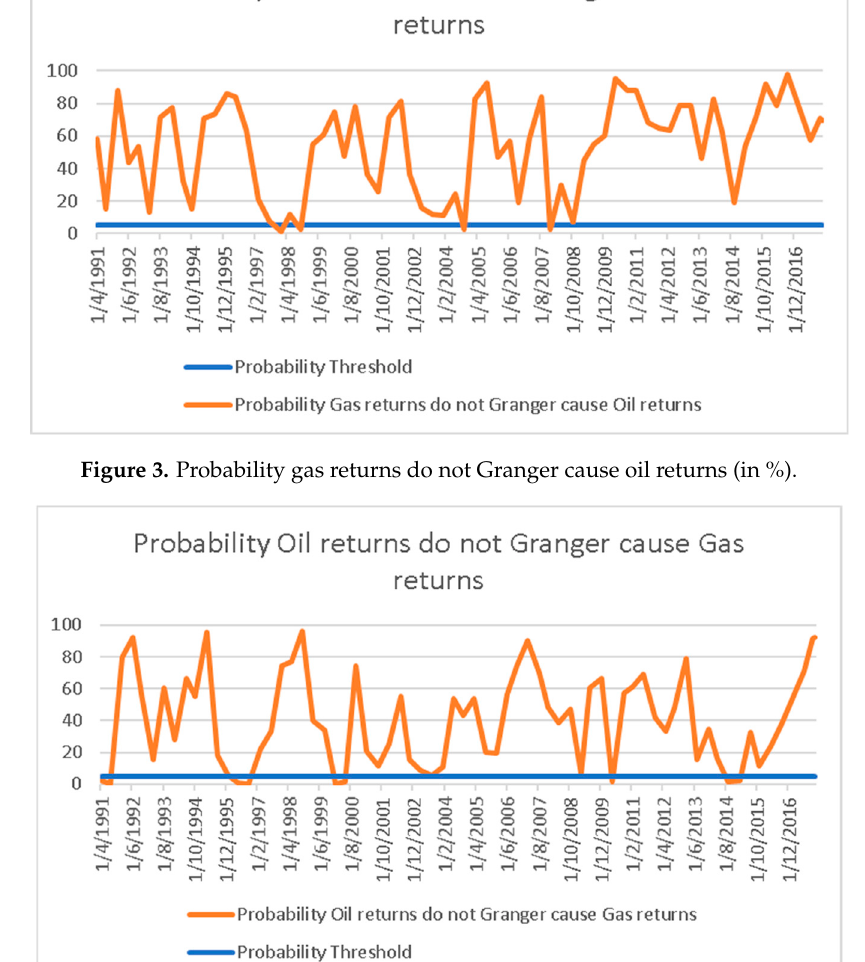
Figure 4. Probability oil returns do not Granger cause gas returns (in %).